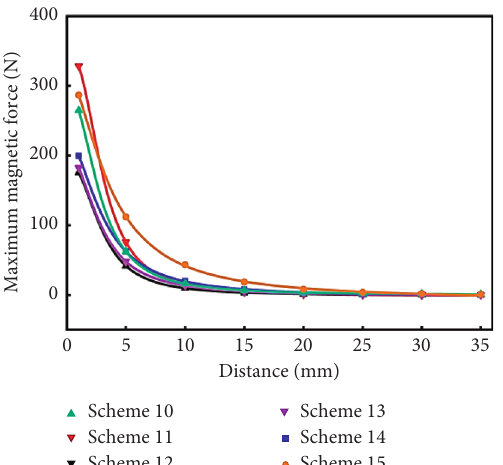
Figure 15: The curve of the relationship between the maximum magnetic force and distance when the valve seat consists of eight identical shape tile magnets.